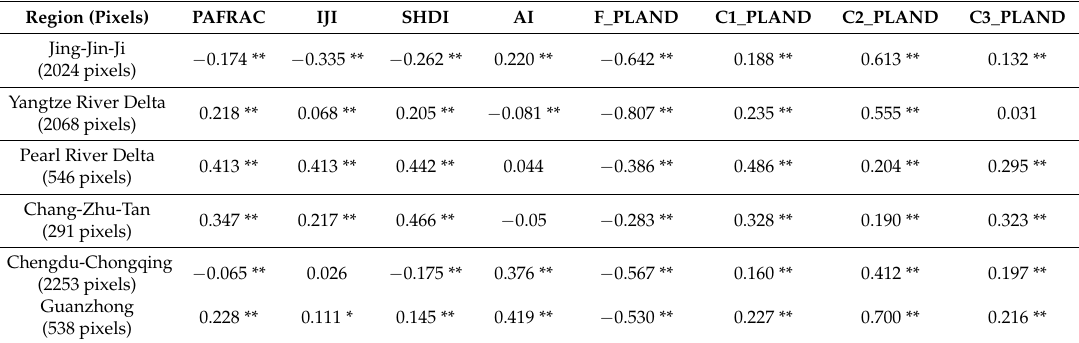
Table 2. Correlation between the landscape with PM 2.5 at 10 km resolution of six urban agglomerations. Region (Pixels) PAFRAC IJI SHDI AI F_PLAND C1_PLAND C2_PLAND C3_PLAND Jing-Jin-Ji − 0.174 ** − 0.335 ** − 0.262 ** 0.220 ** − 0.642 ** 0.188 ** 0.613 ** 0.132 ** (2024 pixels) Yangtze River Delta 0.218 ** 0.068 ** 0.205 (2068 pixels)